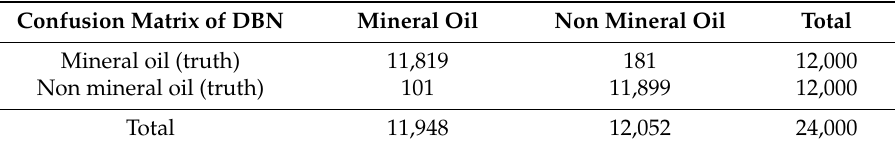
Table 8. DBN Confusion Matrix (20,000 training, 4000 testing, six-fold) derived by DBN.